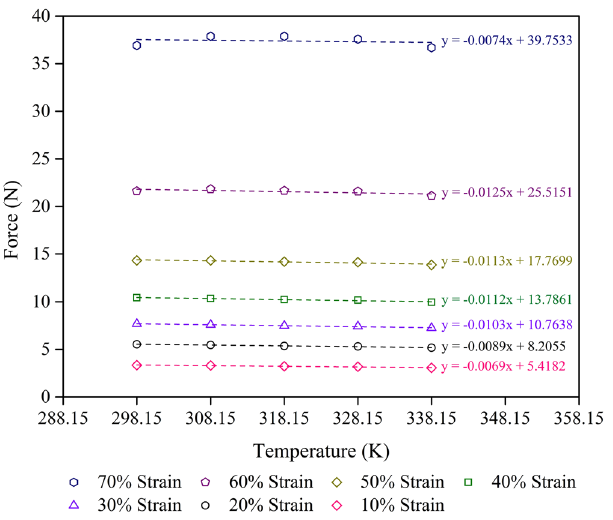
Figure 6. Force–temperature curves at a given strain for the control + 10% NR sample with R 2 = 0.9 minimum at each strain. The scatter on the results is on the order of the size of the